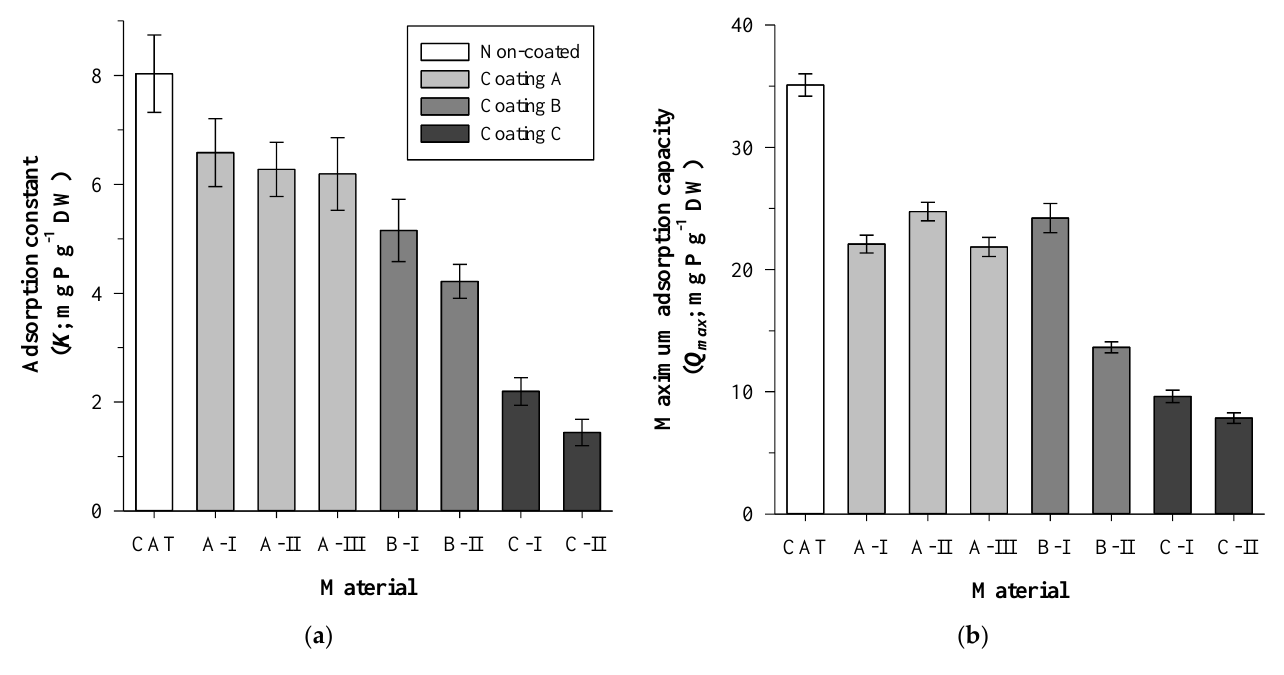
Figure 2. Freundlich and Langmuir adsorption parameters for non-coated and coated CAT materials. (a) Freundlich adsorption constant and (b) Langmuir maximum adsorption capacity. The coated materials were produced from CAT materials with different dilution ratios of the coating (A, B and C) and exposure periods (I, II and II). Values are based on the model fitting ± standard error (SE). The effects of the three coating dilution ratios (A, B and C) were apparent both for K and Q max , as both parameters decreased when the coating became thicker, i.e., as the ratio of the coating base in the coating dilution increased (moving from coating A → B → C) (Figure 2, Table 5). In particular, coating C, i.e., the densest coating with the largest proportion of coating base added in the diluted coating solution, resulted in lower values for K and Q max (Figure 2, Table 5).